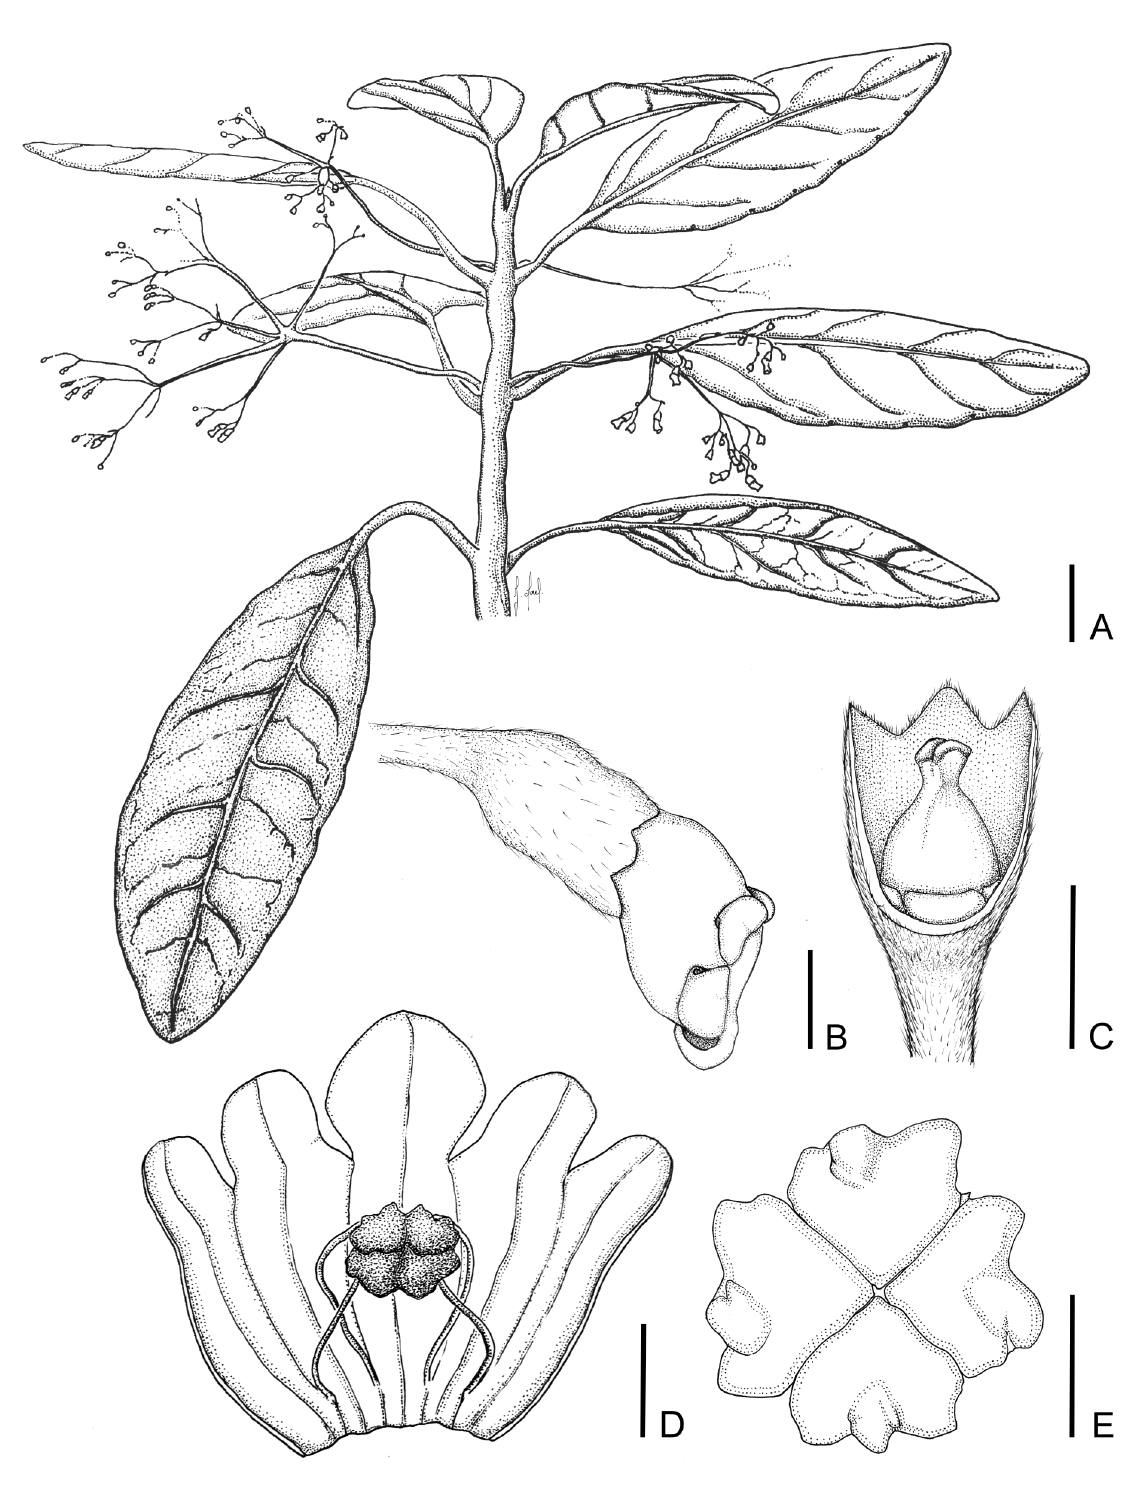
Fig. 5. Bopopia parviflora Munzinger & J.R.Morel gen. et sp. nov. A . Part of plant showing opposite leaves and axillary inflorescences. B . Flower in lateral view. C . Calyx cut open to show the gynoecium. D . Longitudinal section of corolla, showing stamens (lobes unrolled). E . Top view of connate anthers. Scale bars: A = 20 mm; B–D = 1 mm; E = 0.4 mm. Drawn from photographs taken by Jérôme Munzinger and parts of the specimen Munzinger et al. 7980 preserved in